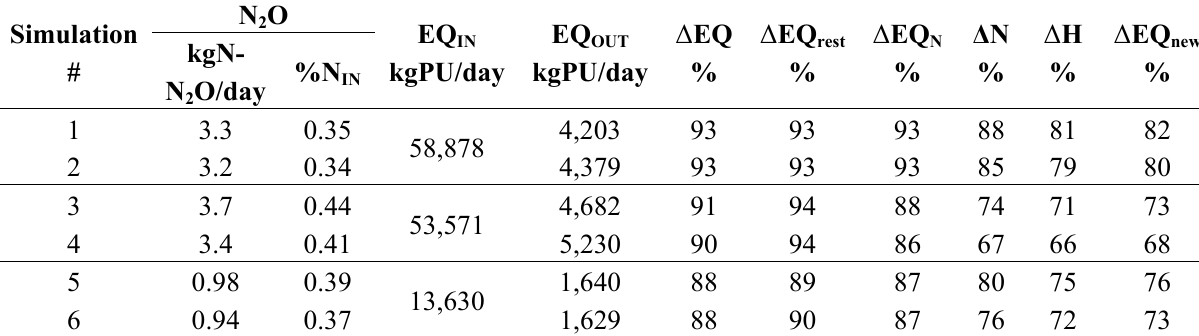
O emissions, traditional effluent quality index (EQ) of the wastewater (EQ Table 3. N 2 and the effluent (EQ ), EQ removal rate ( Δ EQ), EQ removal rate for chemical oxygen OUT demand (COD), biological oxygen demand (BOD), and suspended solids (SS) ( Δ EQ